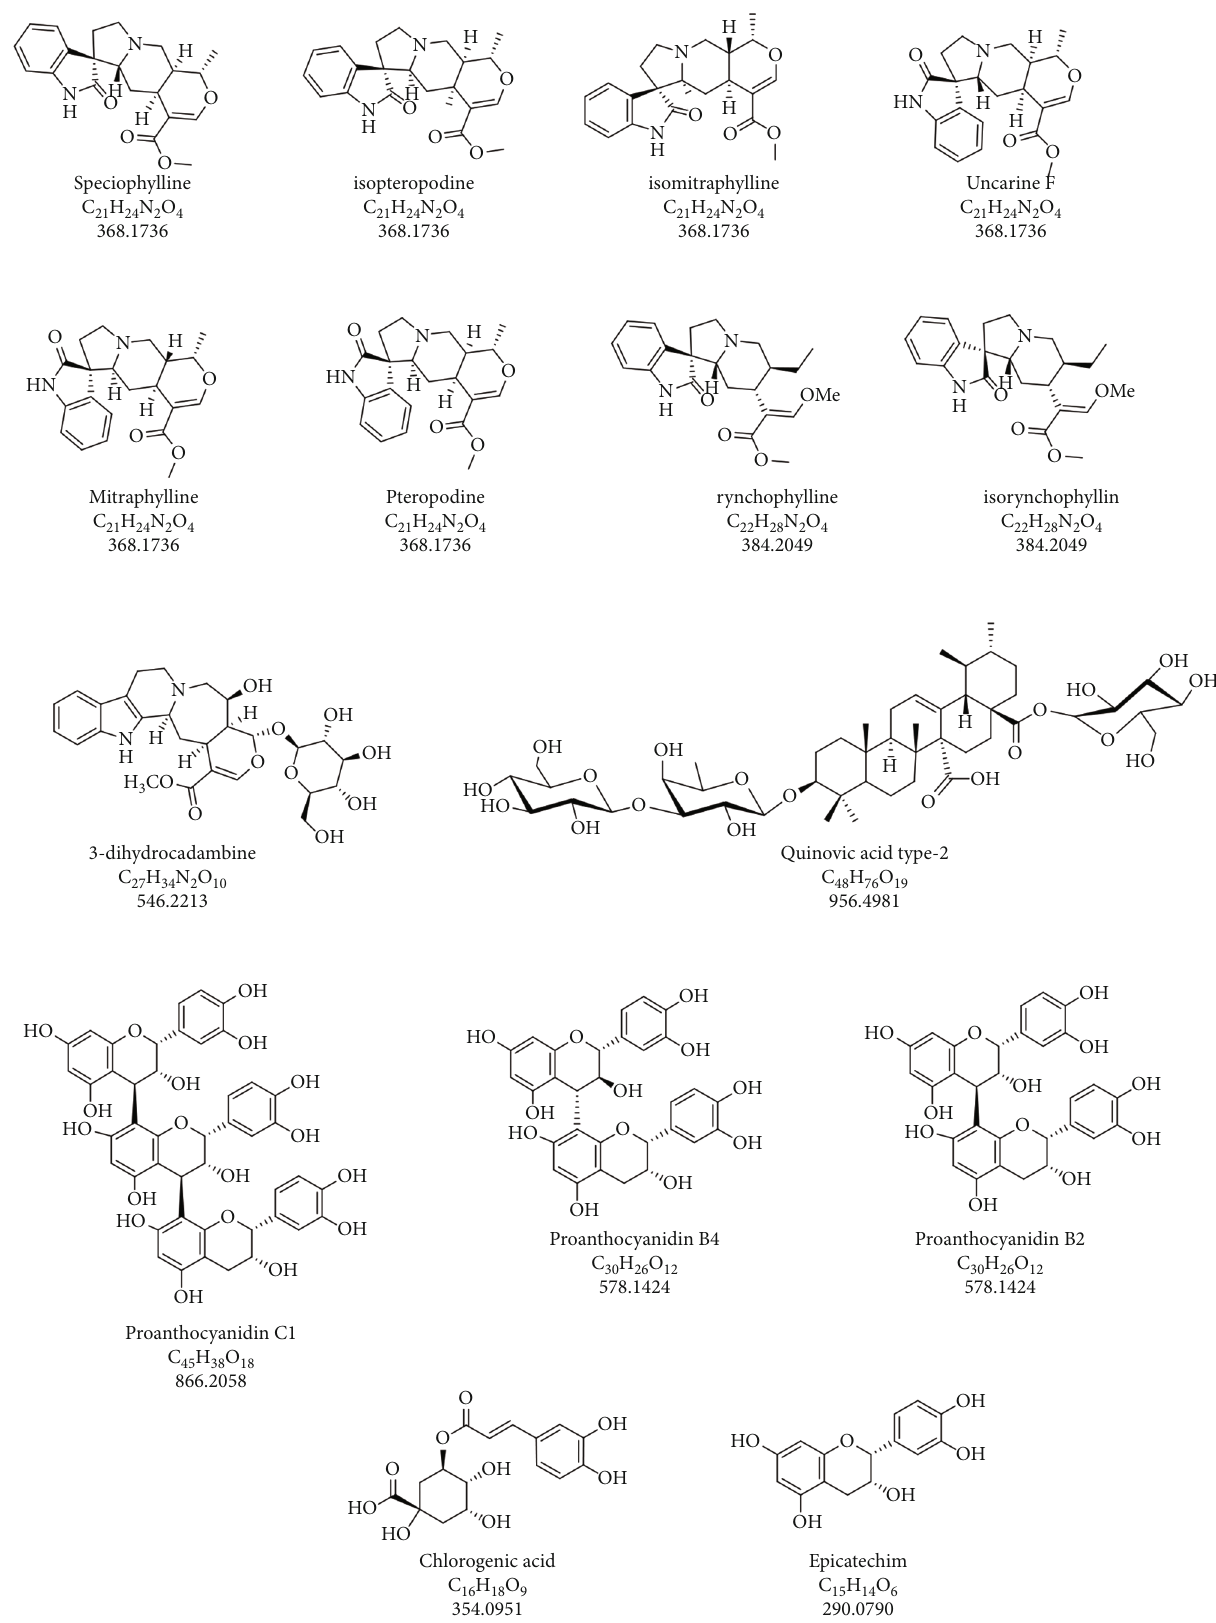
Figure 2: Phytochemical components of the ethanolic extract of U. tomentosa stem